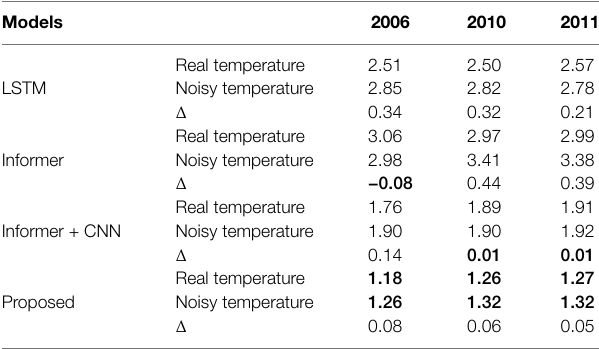
TABLE 7 | Forecast results of the ISO-NE data set using real and noisy temperature data